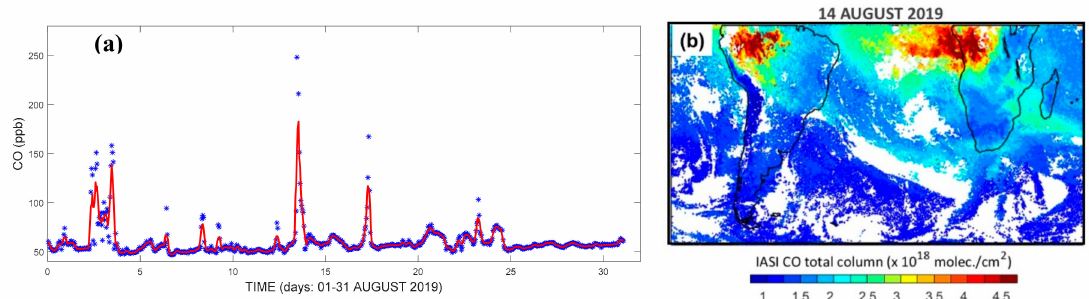
Figure 8. ( a ) Hourly CO values (blue stares symbols) recorded by the Picarro instrument at Cape Point GAW station during August 2019. The red curve represents a 5-h running average. ( b ) Map distribution of CO total columns from IASI observations on 14 August